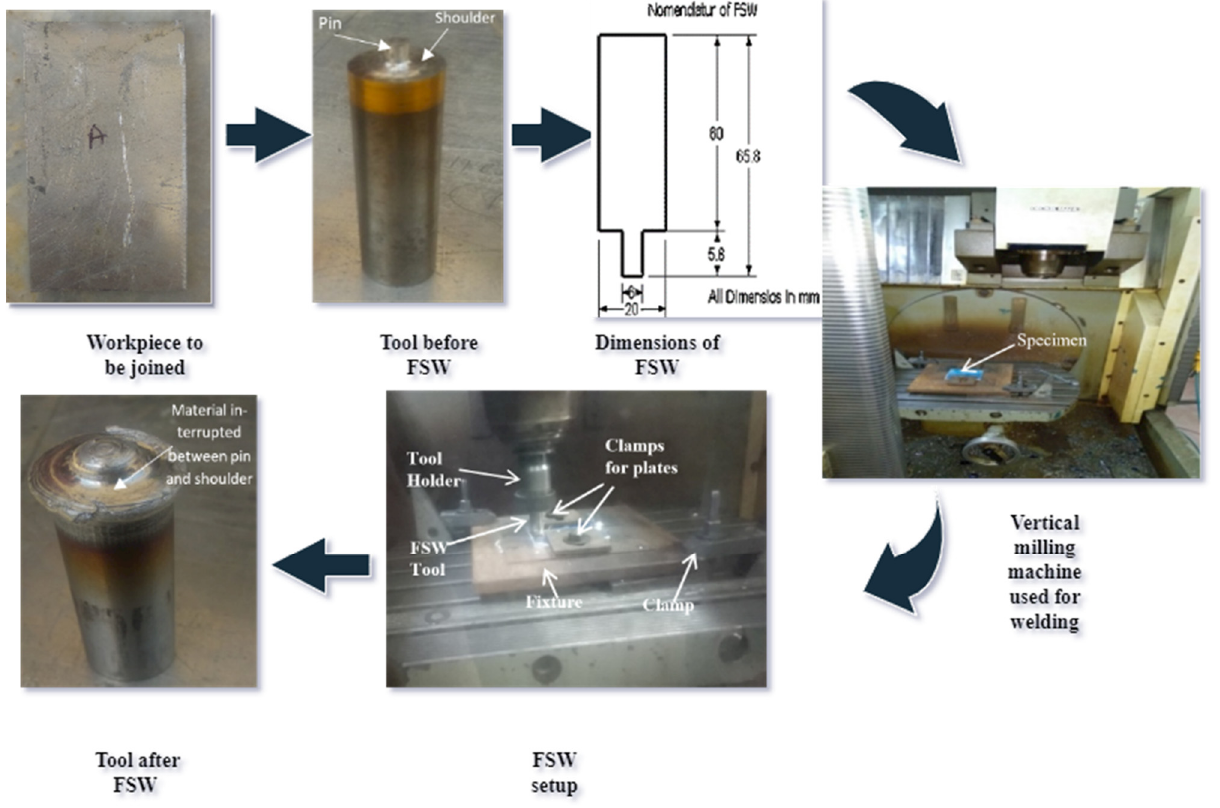
and clamps were used to fix fixtures at the milling machine bed surface. The fixture consisted of a backplate, clamps, and nut bolt. A view of the welded joints is given in Figure 2. The WS was set at 24 m/min and R_s 1200 rpm as per the experimental design. All tests on combinations of designs for FSW were repeated three times. The workpieces to perform different destructive and nondestructive tests. The destructive tests included